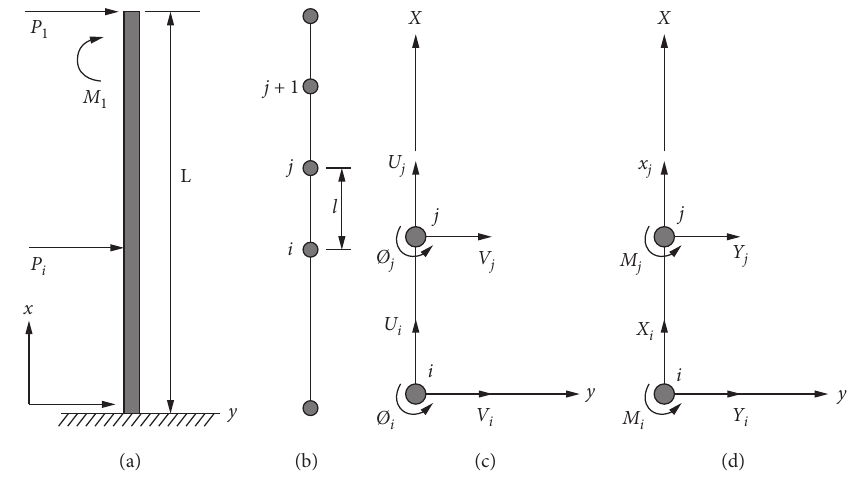
Figure 5: Finite element